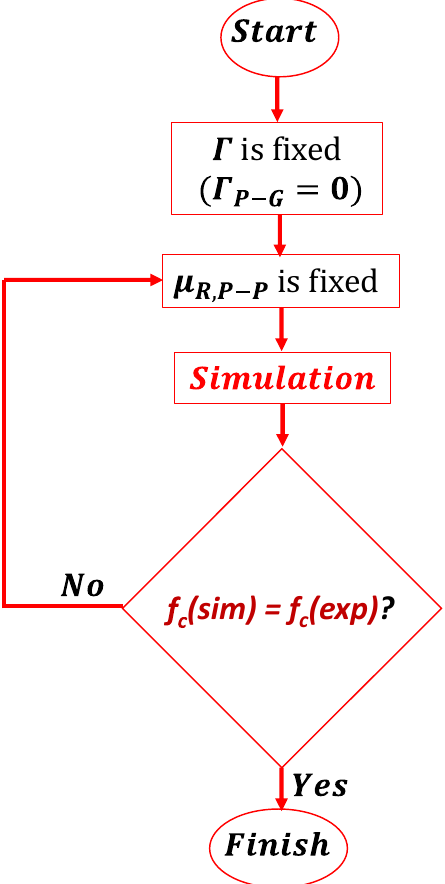
Figure 4. Schematic of the unconfined yield strength calibration methodology in a flow chart. Γ and Γ (cid:2900)(cid:2879)(cid:2891) are the interfacial adhesive surface energy between the particles and between the particles and the geometry, respectively.